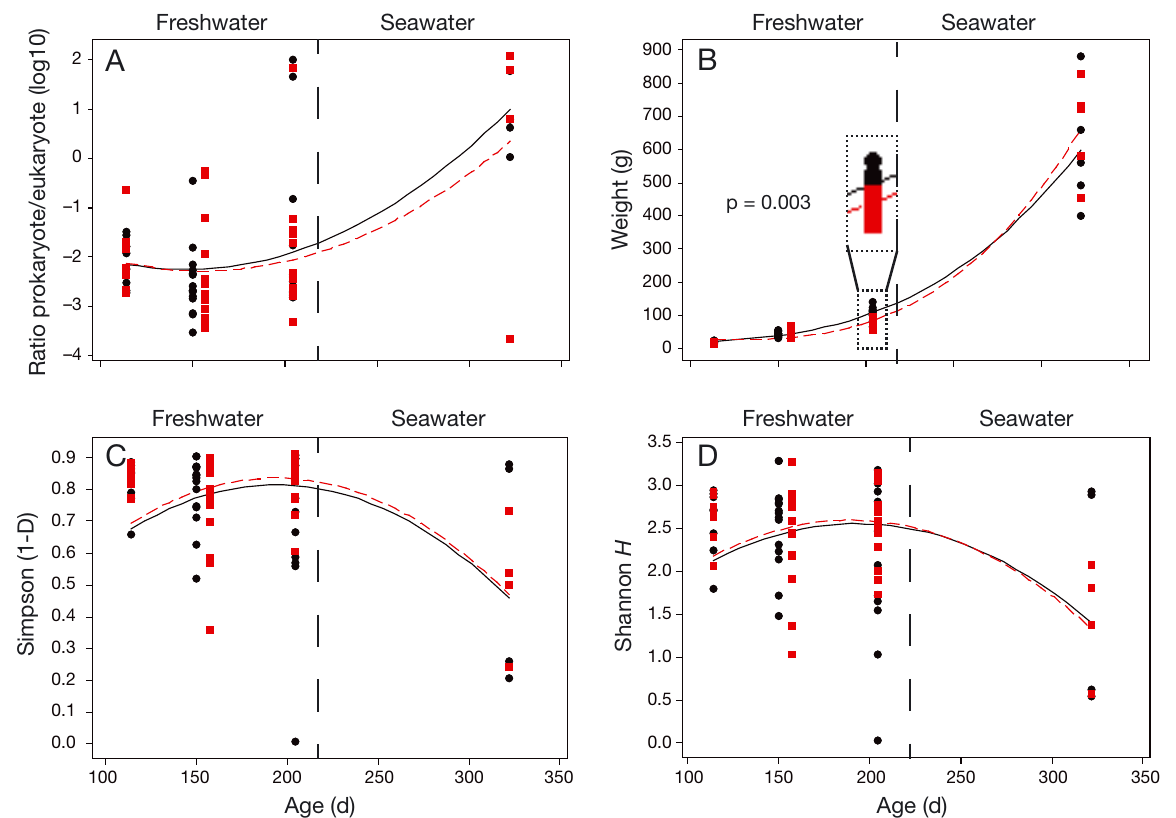
Fig. 3. Age-related development of (A) bacterial load, (B) weight, and (C,D) alpha diversity (C: Simpson index, D: Shannon in- dex), for high long-chain polyunsaturated fatty acids (LC-PUFA) (black circle) and low LC-PUFA (red square) freshwater con- ditions. For (A), bacterial load was determined by the ratio of eukaryote 18S rRNA and prokaryote 16S rRNA gene copies, since this ratio is not affected by the total amount of material analyzed. In (B), the difference in weight at 204 d (dashed out- lines) is significant (Kruskal-Wallis